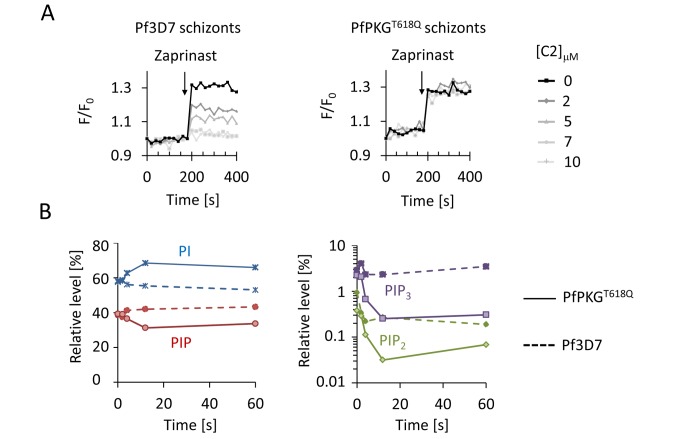
PKG controls phosphoinositide metabolism and Ca2+ mobilisation in P. falciparum schizonts prior to merozoite egress.(A) Relative fluorescence intensity of ∼108 Fluo-4–loaded synchronised P. falciparum schizonts in response to simultaneous exposure to 100 µM zaprinast and increasing concentrations of C2. Data are representative of two independent experiments. (B) Relative abundance over time of PI, PIP (left panel), PIP2, and PIP3 (right panel, note different scale) after simultaneous inhibition of PDEs by zaprinast and PKG by C2. The response of P. falciparum 3D7 (dashed lines) is compared to a transgenic clone expressing the C2-resistant PKGT618Q allele (solid lines).